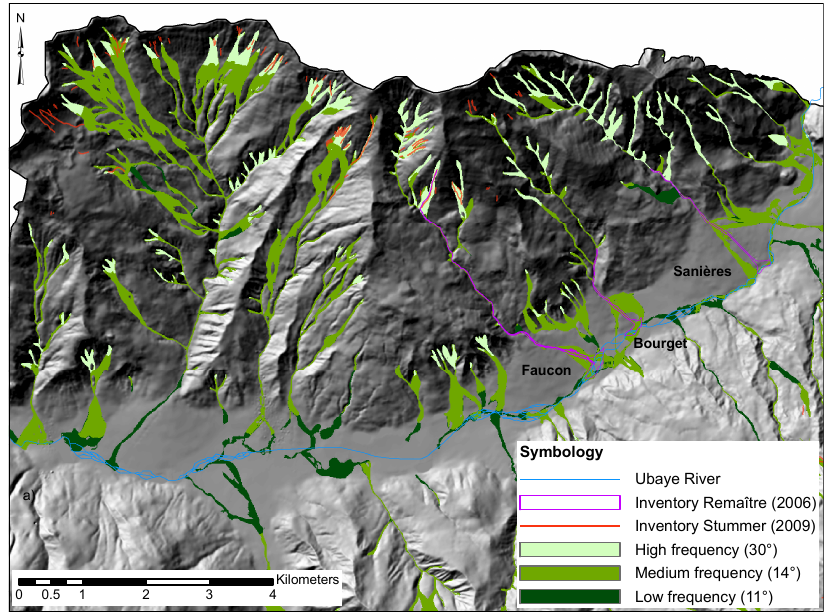
Fig. 9. Modelling results for the qualitative scenarios of high, medium and low frequency in comparison with the inventory after Stummer (2009) and the envelopes of events in 1996, 2002 and 2003 (Remaˆıtre, 2006), showing the south-facing slopes.